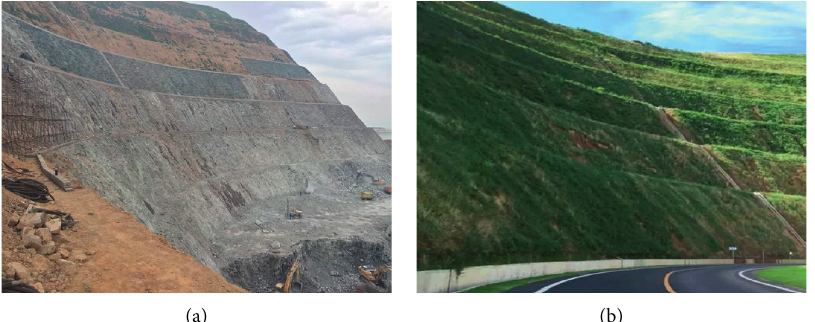
Figure: 11: Map of the project site. (a) Formation of the rock slope. (b) Slope greening